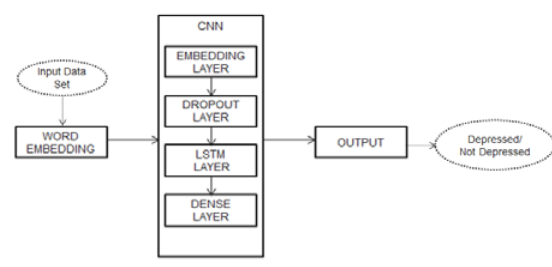
Fig.2. System Design using